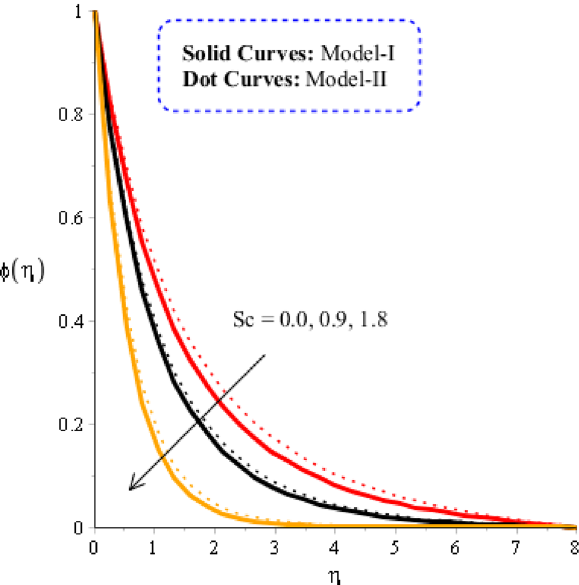
Figure 10. Graphical impact of Sc on concentration distribution when α = 0.5, m = 0.3, Re = 4.0, we =